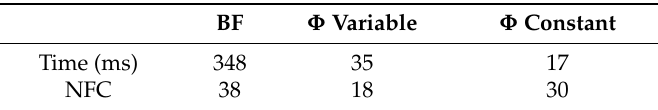
Table 4. Comparison of solution